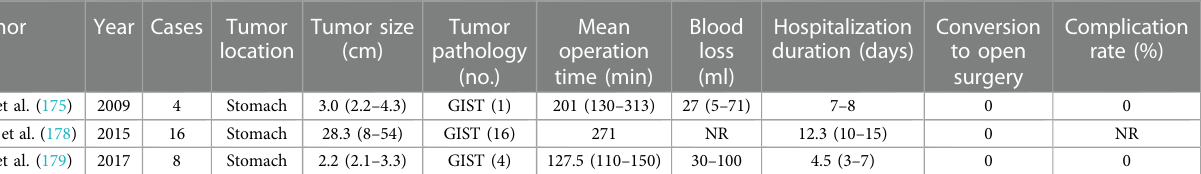
TABLE 12 Research studies of the LAEFR technique.